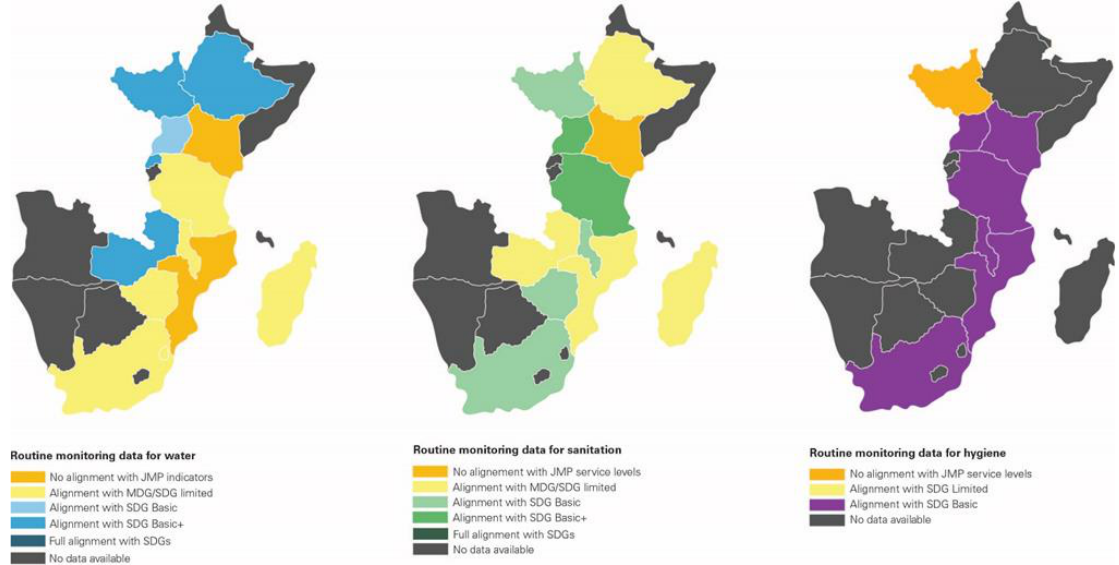
Figure 5. Availability of data in routine monitoring systems, and extent of alignment with JMP in- dicators for access to drinking water services, access to sanitation services and access to hygiene [30].